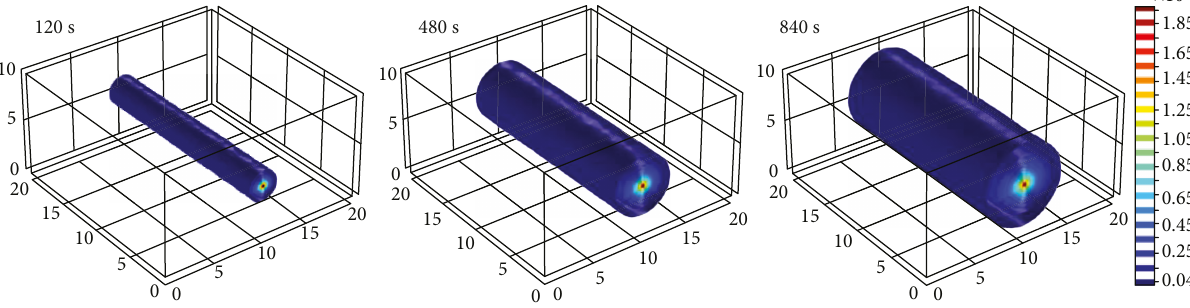
Figure 13: Contour of slurry pressure (grouting pressure p = 2 MPa; water-cement ratio of expandable slurry with high water content, W:C =7:1).